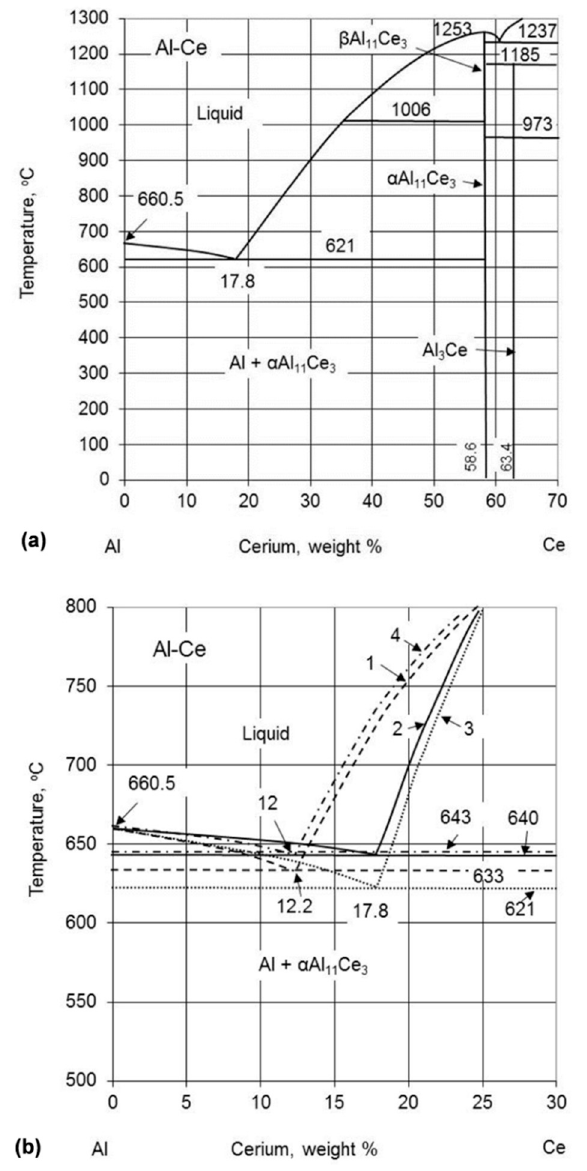
Figure 1. The Al rich portion of the Al–Ce phase diagram by Okamoto, 2011 [11] ( a ) and examples of the literature differences in the coordinates of the eutectic point (1) [12] 1990, (2) [13] 1998, (3) [11] 2011, (4) [14] 2017 ( b ). Values of the coordinates of the eutectic point, published within the last three decades, are listed in Table 1. Figure 1a was adapted from [11].